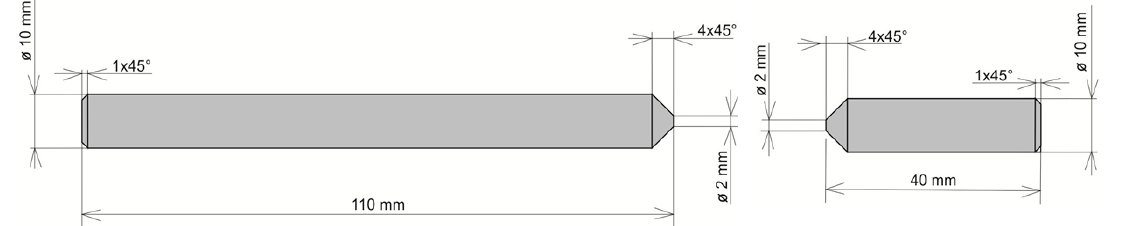
Figure 5. Alpha-geometry of the weld surface for the evaluation of the fatigue characteristics.